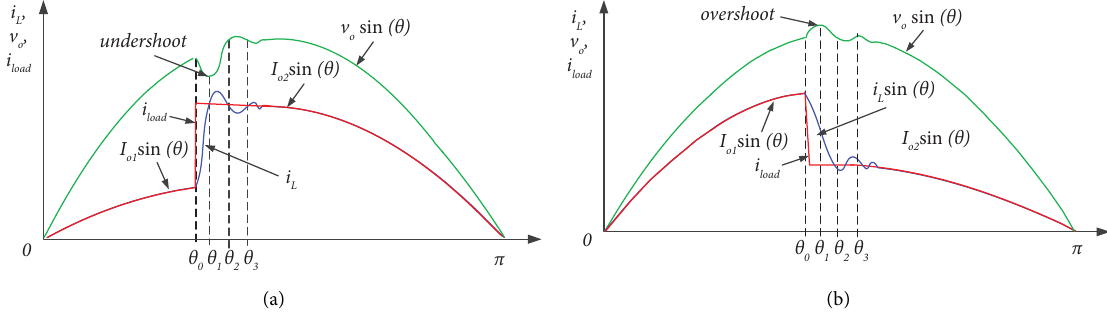
Figure 3: Transient response of the single-phase VSI with the linear controller in response to load current. (a) Positive step change. (b) Negative step